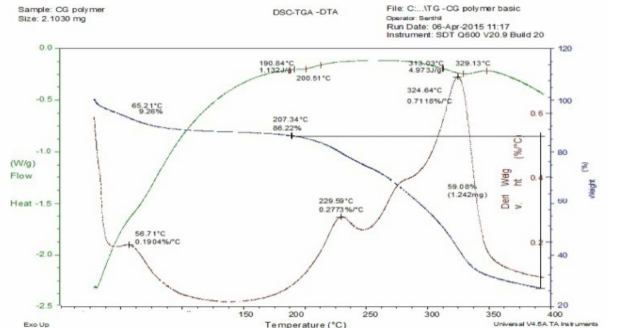
Figure 1. DSC, TGA, DTA of mucilage (CGM).